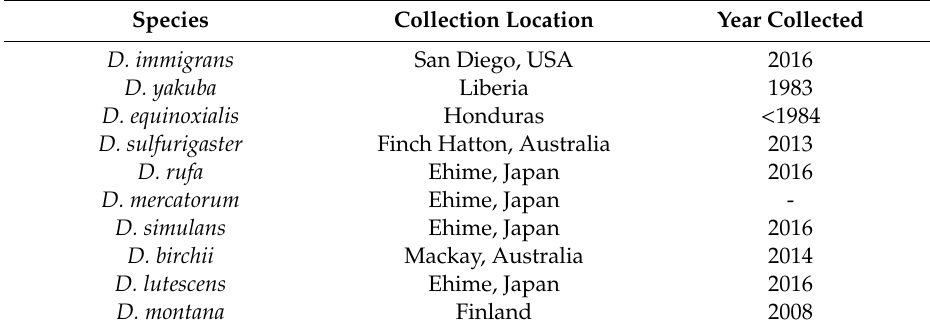
Table 1. Origin and collection year of Drosophila species used in this study.